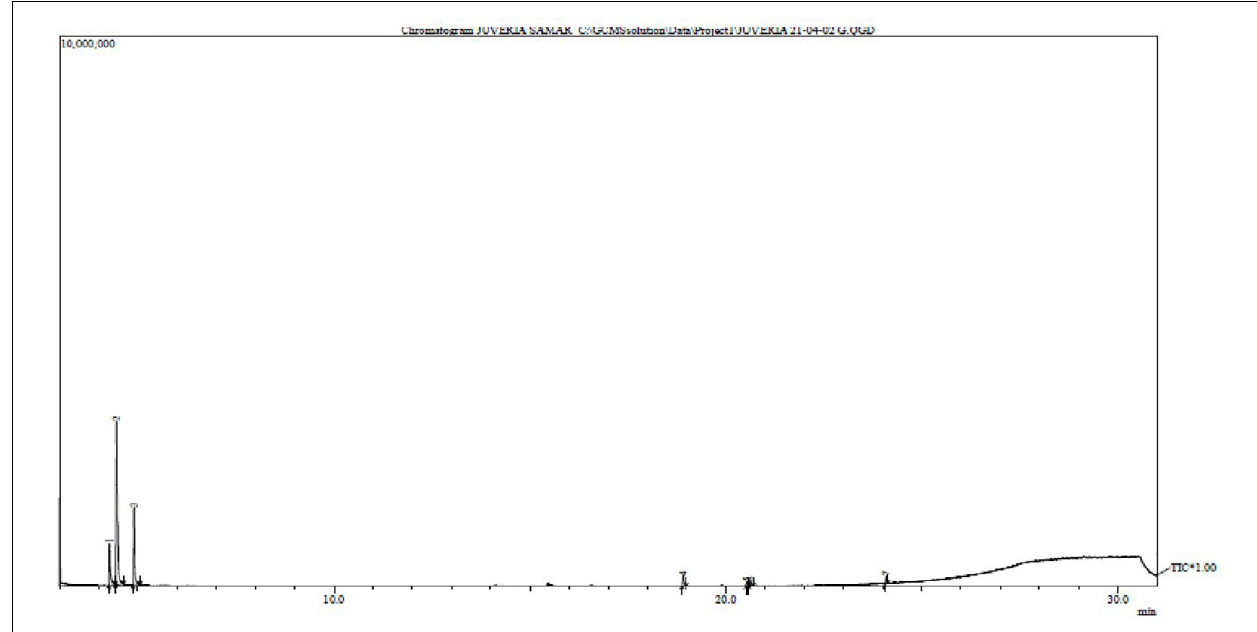
FIGURE 4 | Gas chromatography – mass spectrometry chromatogram of Padina antillarum (Kützing) Piccone.